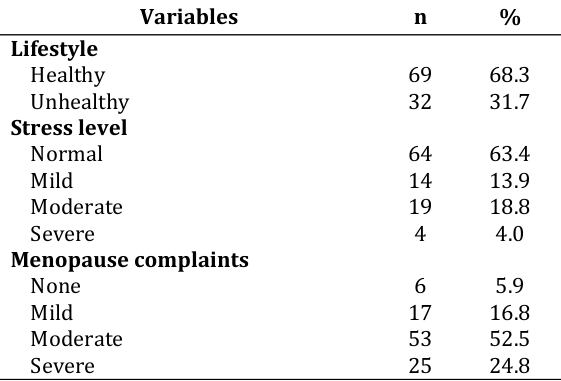
Table 2. Lifestyle, Stress Levels, and Complaints